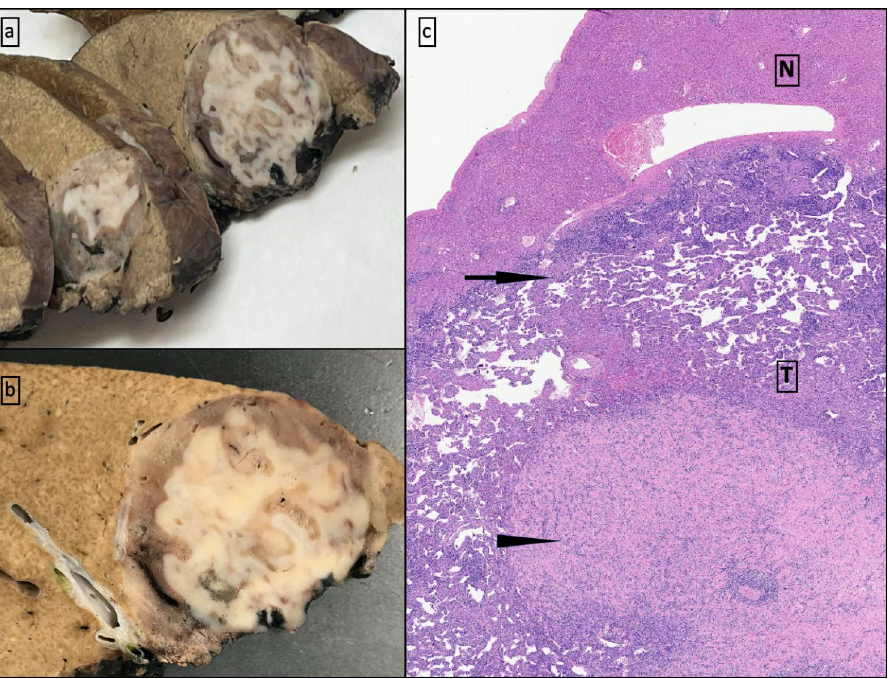
Fig. 3 Hepatic parenchyma sections with a rounded and solid tumoral lesion of striped appearance ( a and b ). Panoramic macroscopic-microscopic view of normal tissue of the liver (N) and tumor (T). Two different components can be identified: the hypercellular and vascularized zone (arrow) corresponding to macroscopic brownish bands and the main sclerosing hypocellular region (arrowhead)